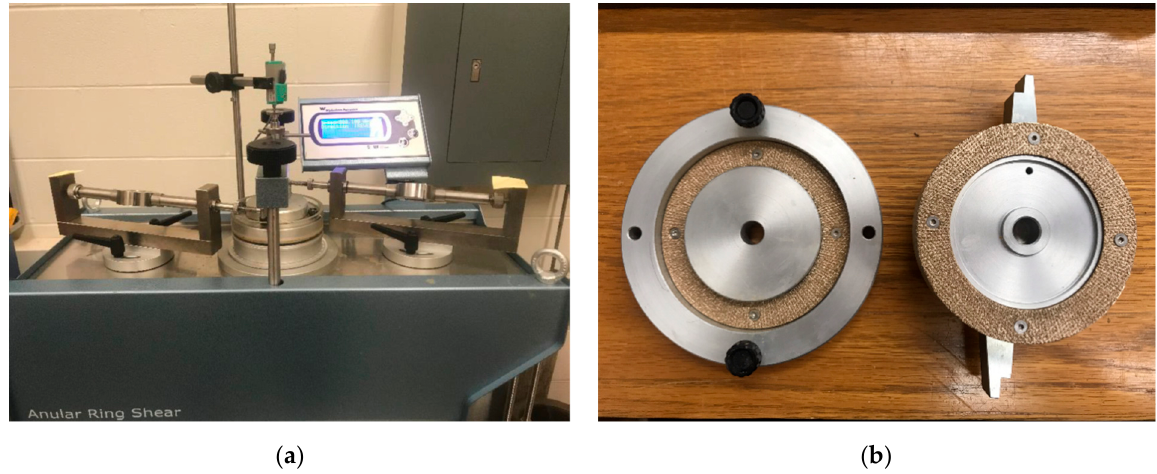
Figure 5. Torsional ring shear apparatus: ( a ) control group Bromhead ring shear apparatus; ( b ) modified porous stones used in this study.